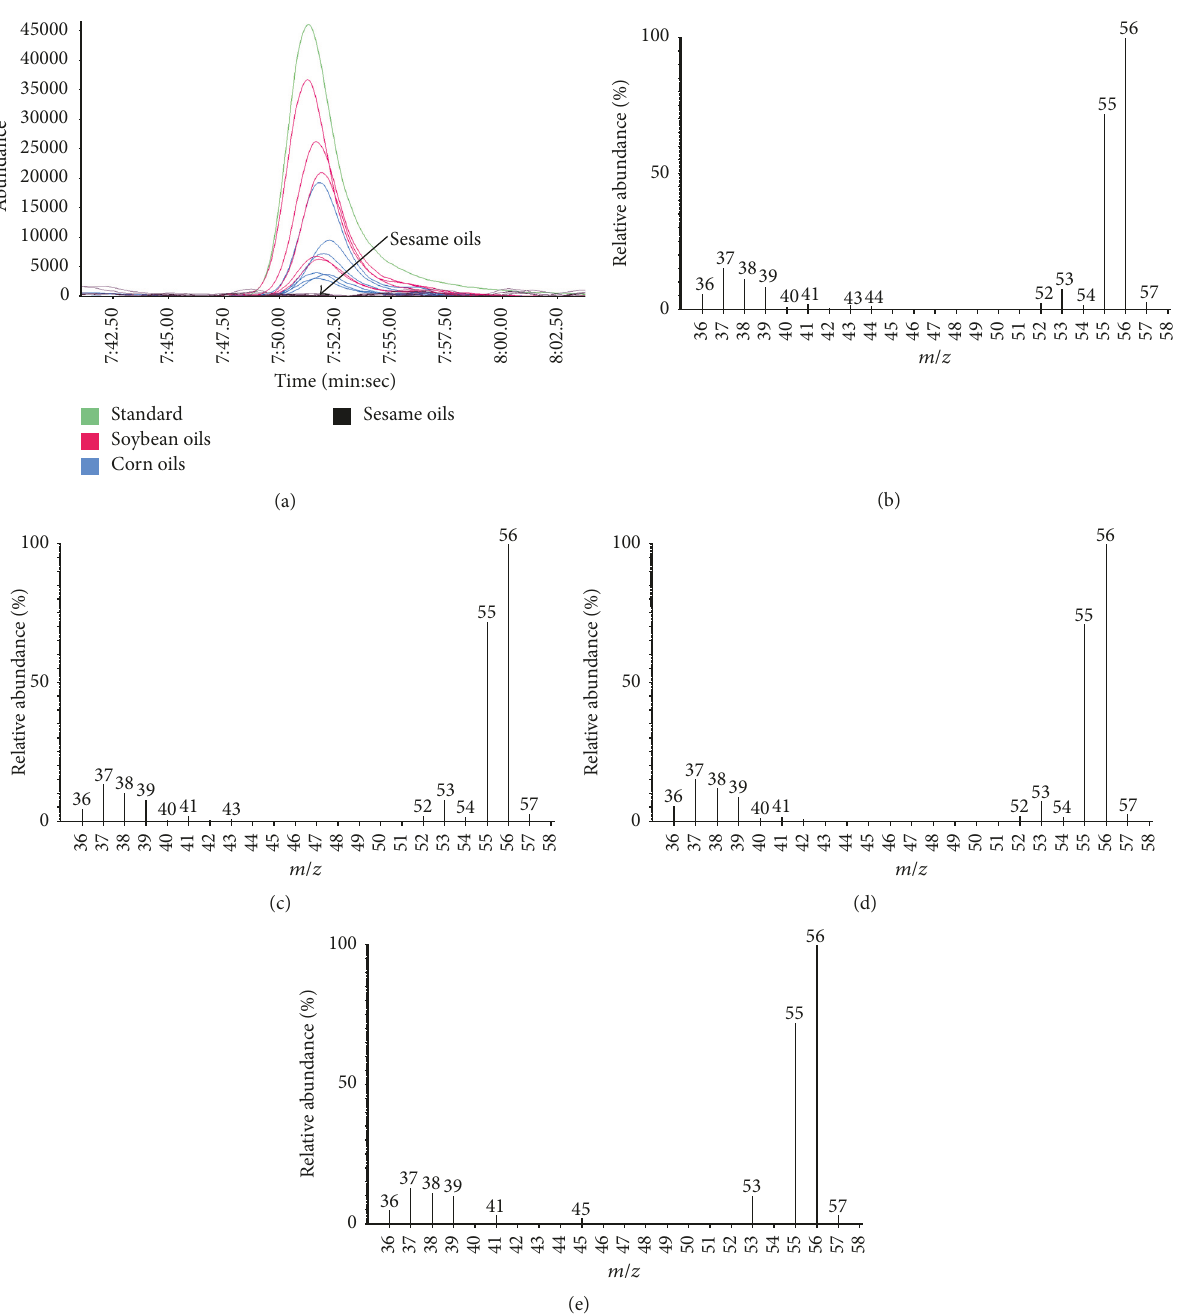
Figure 1: Chromatograms of 2-propenal in six corn oils (blue line), five soybean oils (red line), and twelve sesame oils (black line) analyzed using GC-TOF/MS (a). Similar MS spectra of 2-propenal in corn oil (b), soybean oil (c), authentic standard (d), and Wiley library (e) were detected at 70 eV of electron